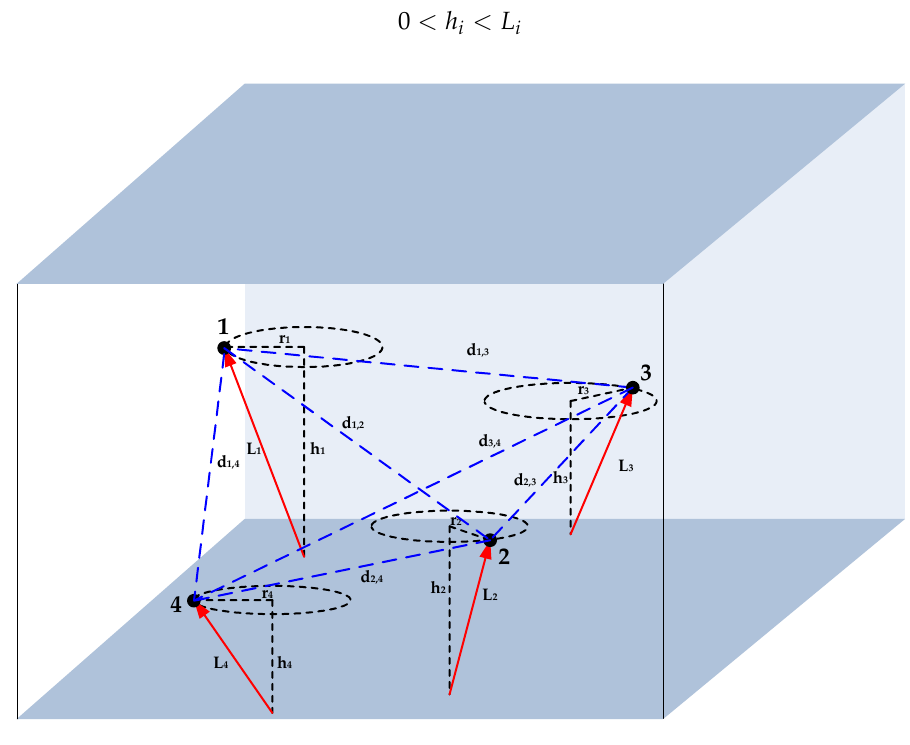
Figure 1. Network